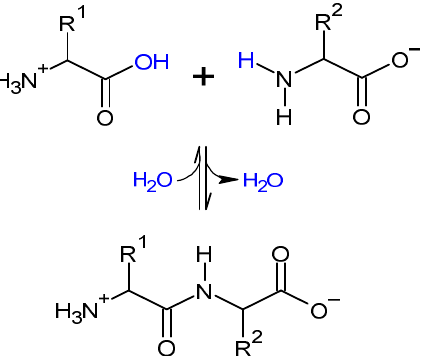
Figure 2. Formation of a peptide bond between two amino